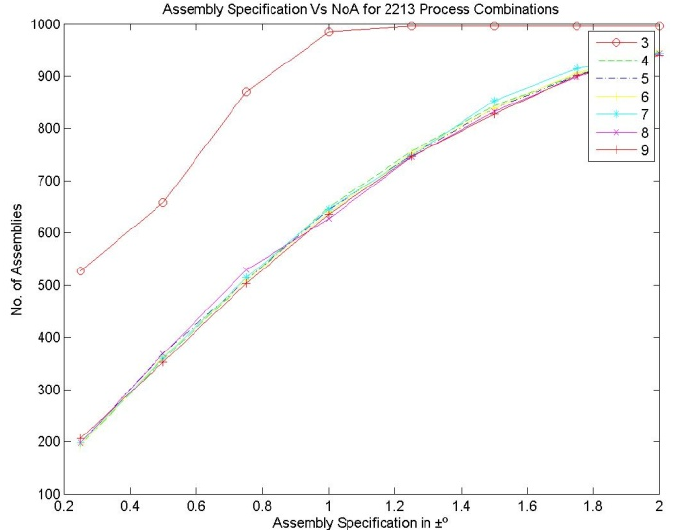
Figure 8. Assembly specification vs. NoA for various bin numbers—the 1213 process combination.